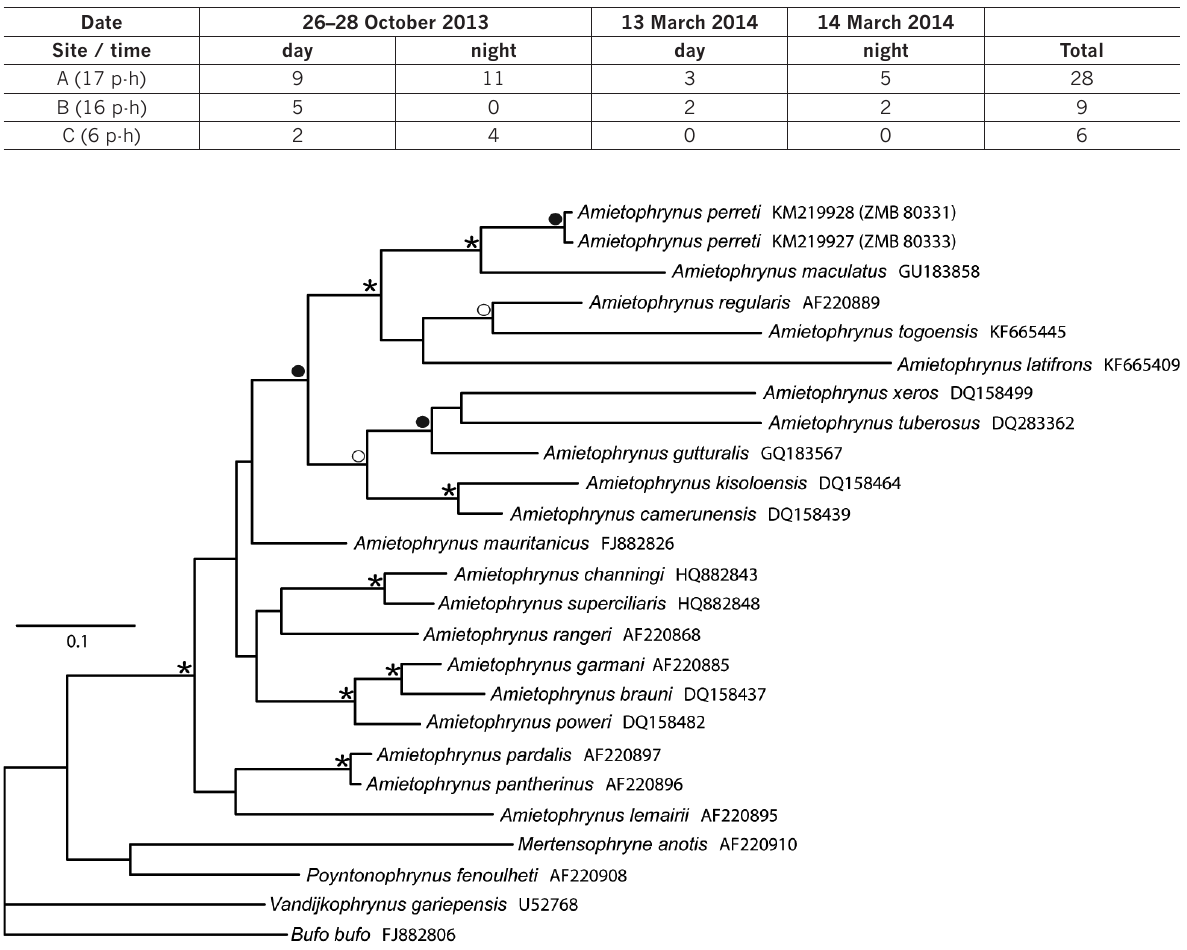
Table 2. Number of Amietophrynus perreti observed at the three study sites (compare Table 1 and site descriptions in material and methods section).